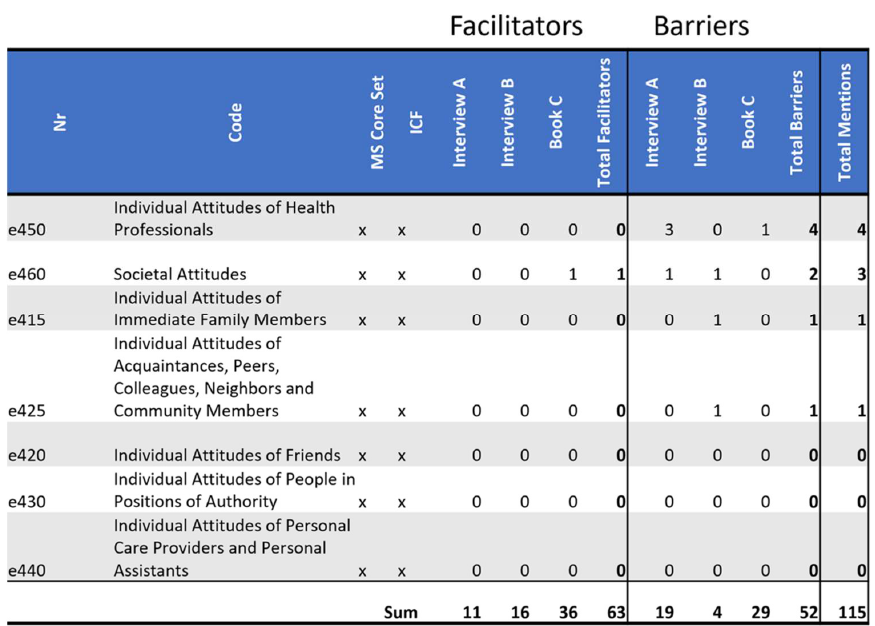
Figure 7. Distribution of codes in the domain e4 Attitudes : This figure shows the frequency of MS core set codes and non-core set codes of this domain referenced in each source as a facilitator and as a barrier. Additionally, it tallies all references throughout the domain as facilitators or as barriers by source, as well as talling facilitators and barriers separately and together by code.